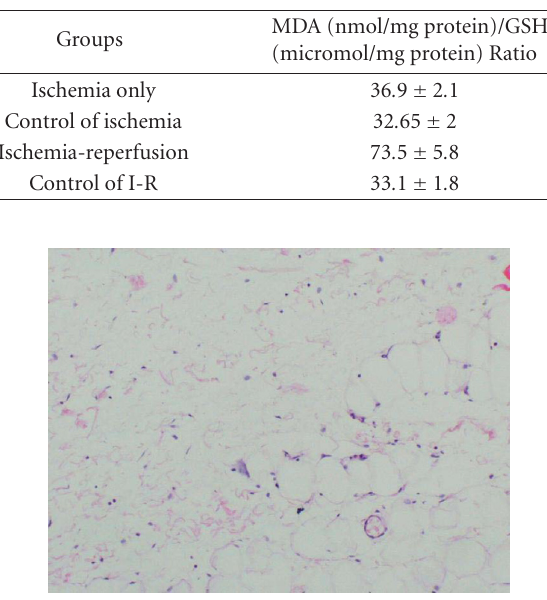
Figure 1. Marked edema in the adipose tissue after ischemia is seen (H&E, × 50).